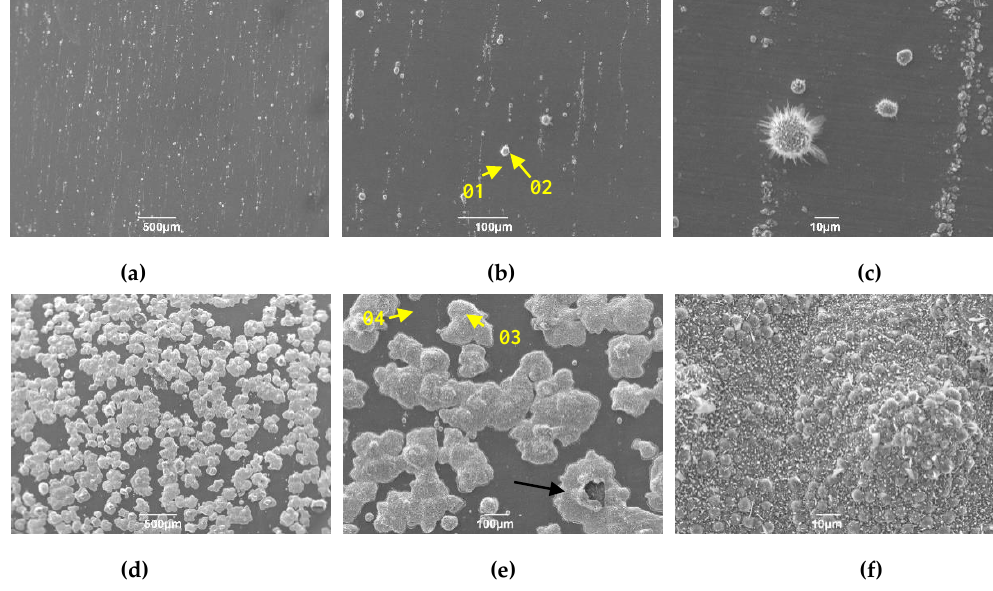
Figure 5. Surface morphology of TP347H and TP347HFG at 700 °C after 168 h. ( a ) TP347HFG; ( b ) TP347HFG; ( c ) TP347HFG; ( d ) TP347H; ( e ) TP347H; ( f ) TP347H.